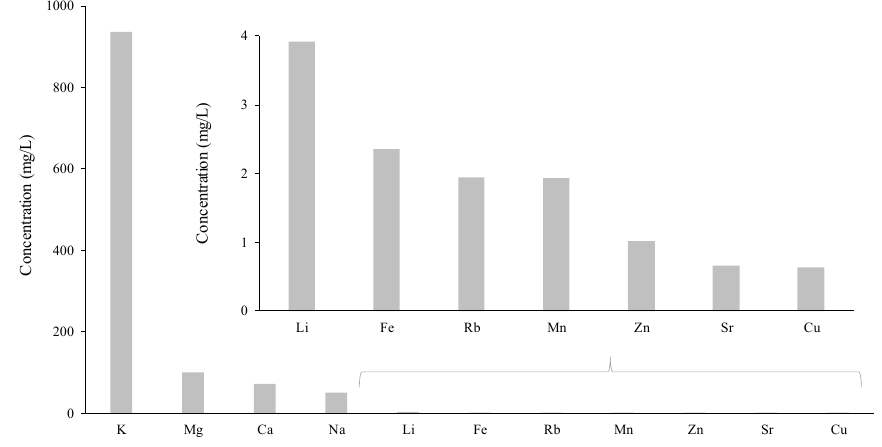
Figure 8. Concentration of metals in Madeira wine (adapted from the work of [157]).